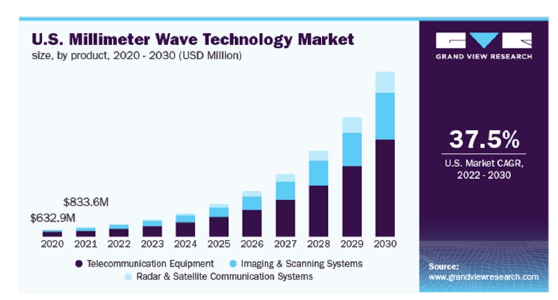
Figure 7. Capacity trend in Gbps for 28GHz mm-wave networks using 65 0 and 30 0 transmitting antenna beam-widths